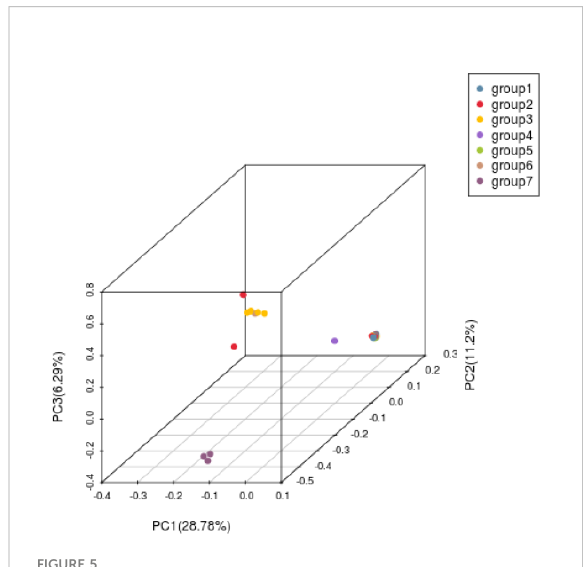
FIGURE 5 Principal component analysis diagram of H. hainanensis.